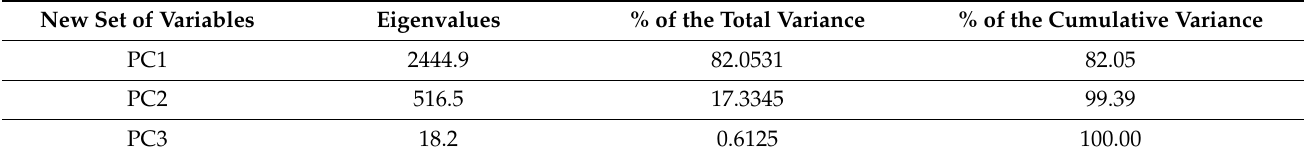
Table 3. Eigenvalues and percentage of the variance of each principal component.